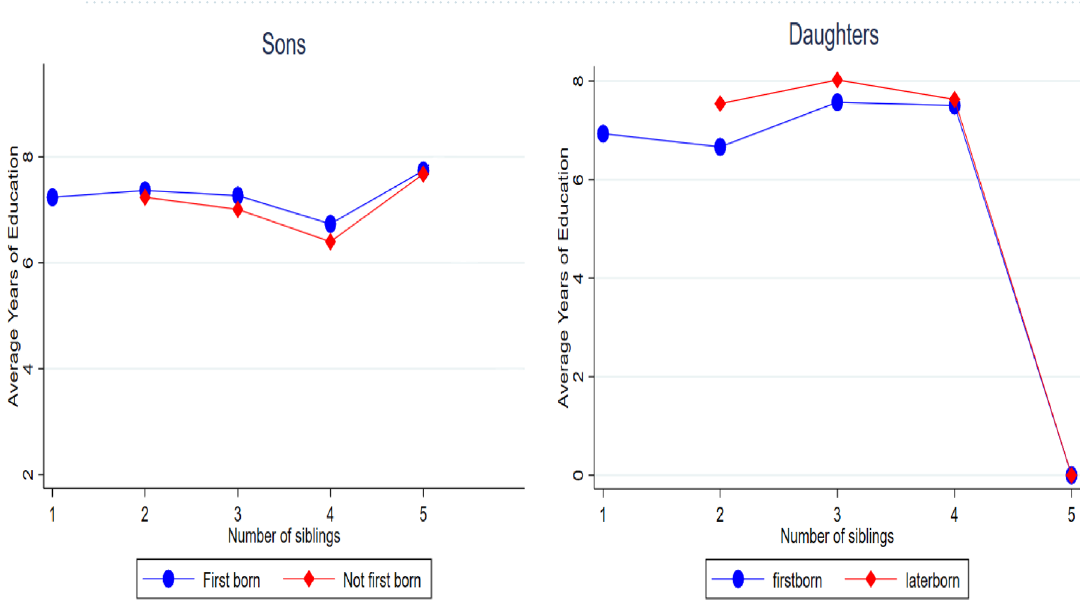
Figure 1. Distribution of years of schooling of sons and daughters by birth order. The first panel shows the relationship between cumulative distributions of education (Y axis) of sons by birth order and years of schooling (X axis). The second panel shows the relationship for daughters.